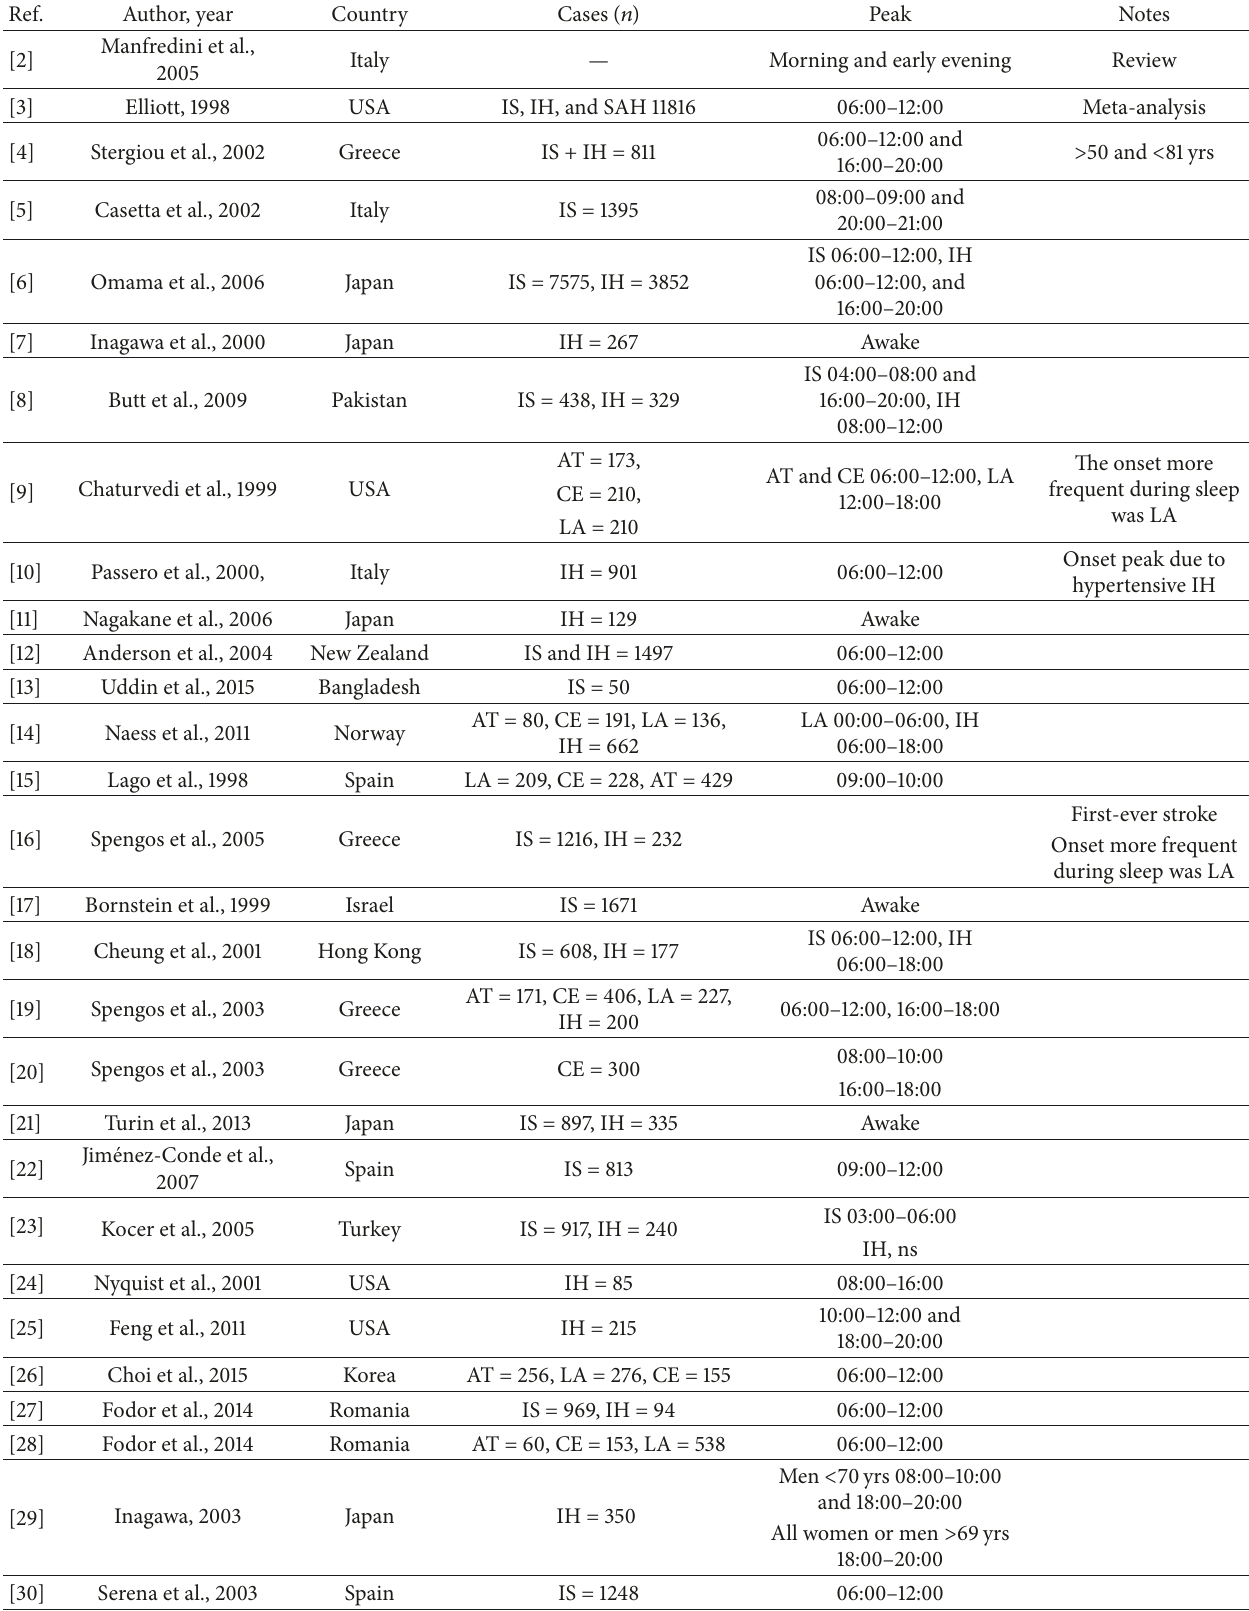
Table 1: Available evidence on circadian pattern of onset of